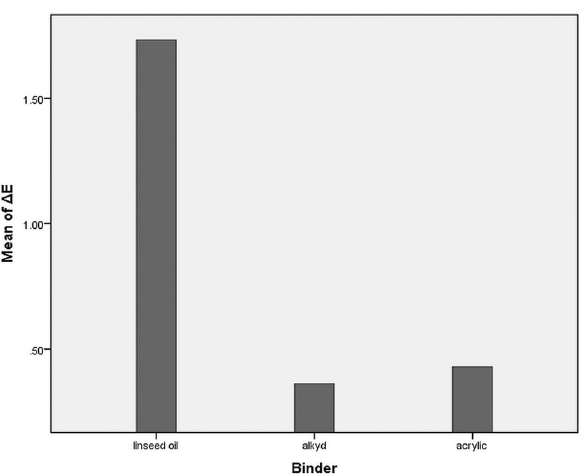
Figure 4. Correlation between colour change (mean of ΔE) and binding medium used for the mock-ups (acrylic, alkyd, and linseed